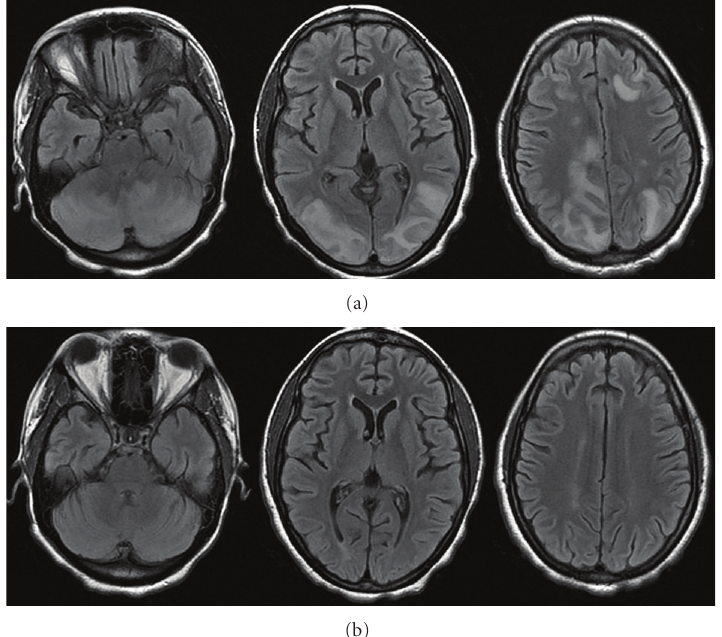
Figure 1: (a) Axial MRI scan (FLAIR sequence) displays multiple bilateral hyperintense lesions a ff ecting the white matter of cerebellar hemispheres and of frontal, occipital, and parietal lobes. (b) At followup (one week later) the same sequence shows a complete resolution of all